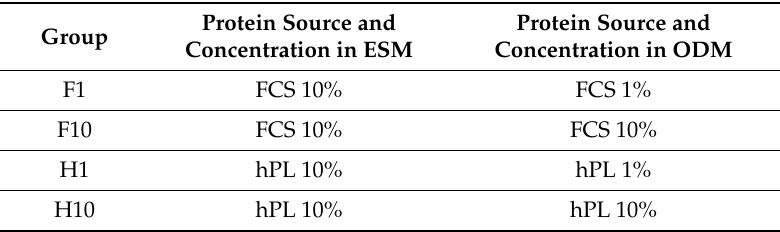
Table 1. Overview over the experimental